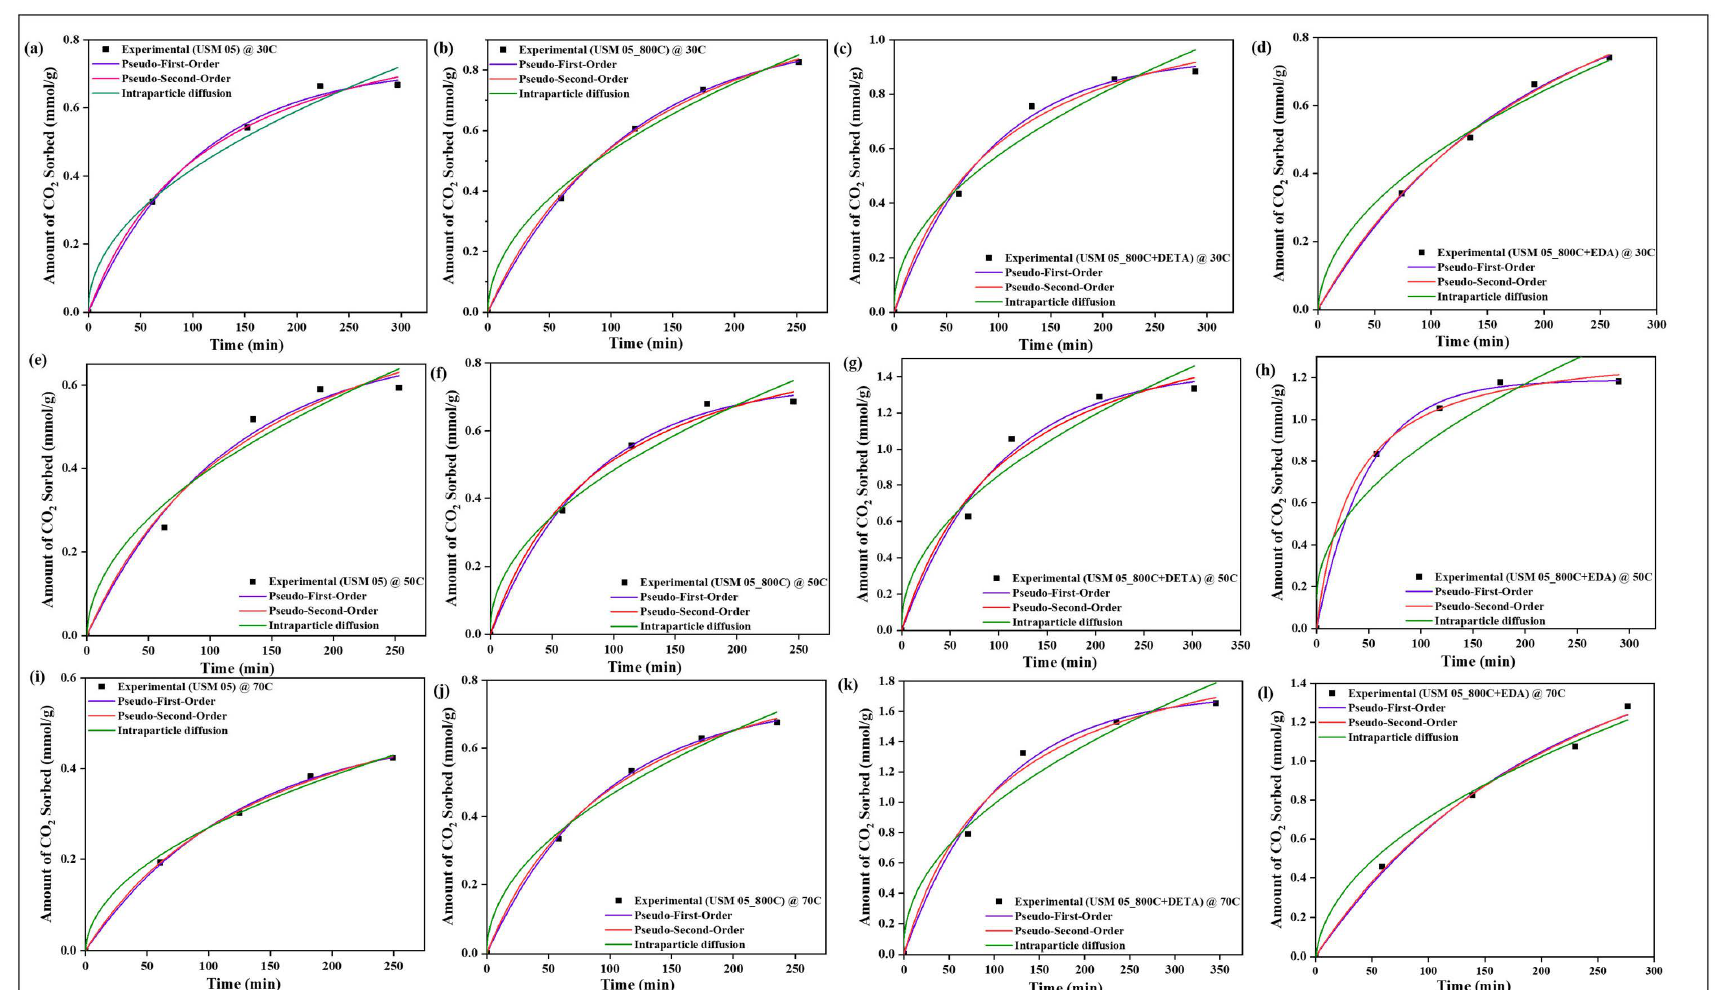
Figure 16. The prediction of sorption rate mechanism on USM 05 variants at 30 ◦ C ( a – d ), 50 ◦ C ( e – h ), and 70 ◦ C ( i – l